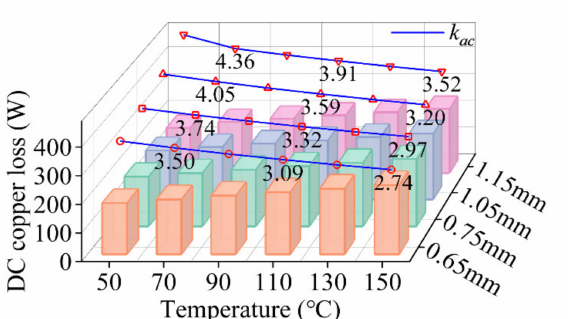
Figure 25. DC Copper loss and AC/DC copper loss ratio k ac with the temperature at different conductors.